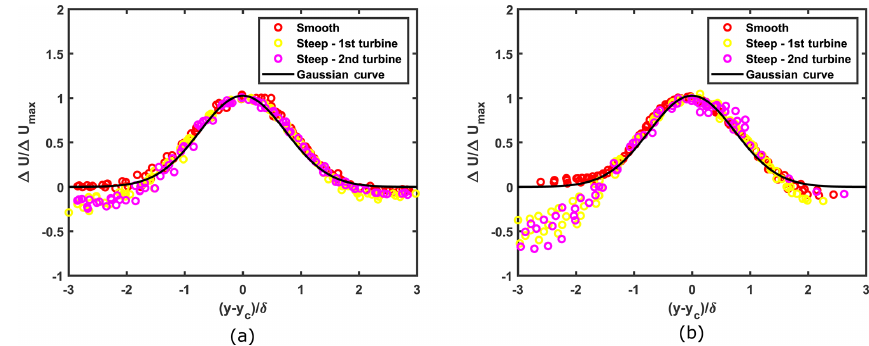
Figure 15. Self-similar lateral profiles of streamwise velocity deficit for complex cases accounting for wake deflection in the vertical direction for a downstream distance of (a) 1D to 3.5D and (b) 4D to